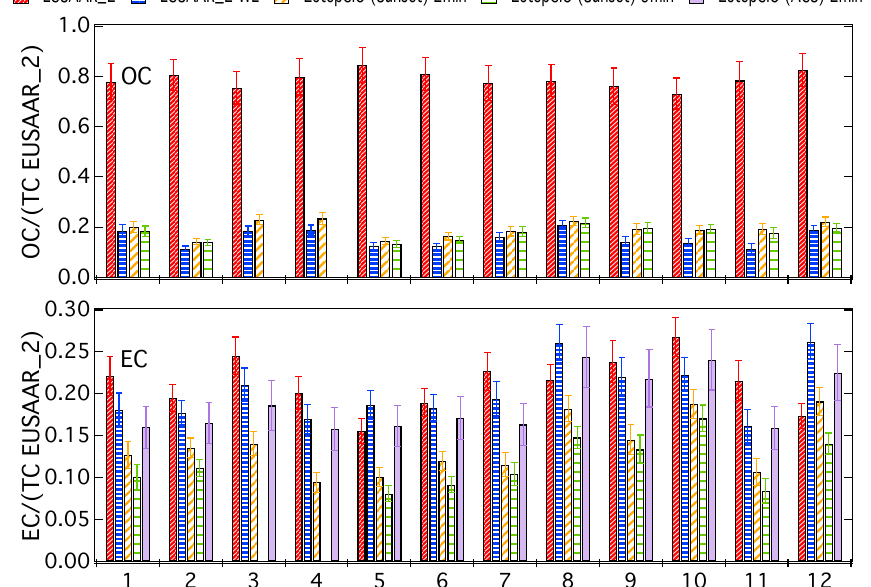
Figure A2. OC and EC concentrations relative to the TC concentration determined with the EUSAAR_2 protocol on untreated filter samples—determined with the EUSAAR_2 protocol on untreated (EUSAAR_2) and water-extracted (EUSAAR_2 WE) filter samples and determined with the 2stepCIO protocol on the Sunset analyzer with an intermediate step (450 ◦ C) of 2min (2stepCIO (Sunset) 2min) and 3 min (2stepCIO (Sunset) 3 min) and the 2stepCIO protocol on the ACS (2stepCIO (ACS) 2min) for all investigated